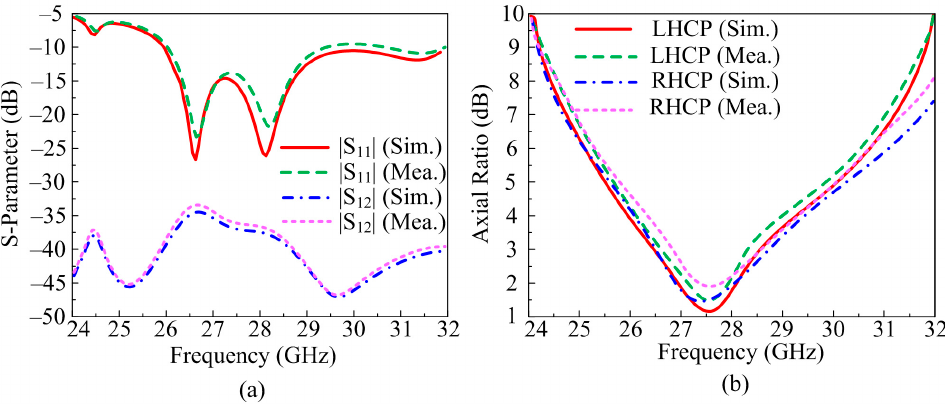
Figure 13. Comparison of results of MIMO antenna with orthogonal placement of element ( a ) scattering parameters ( b ) axial ratio.